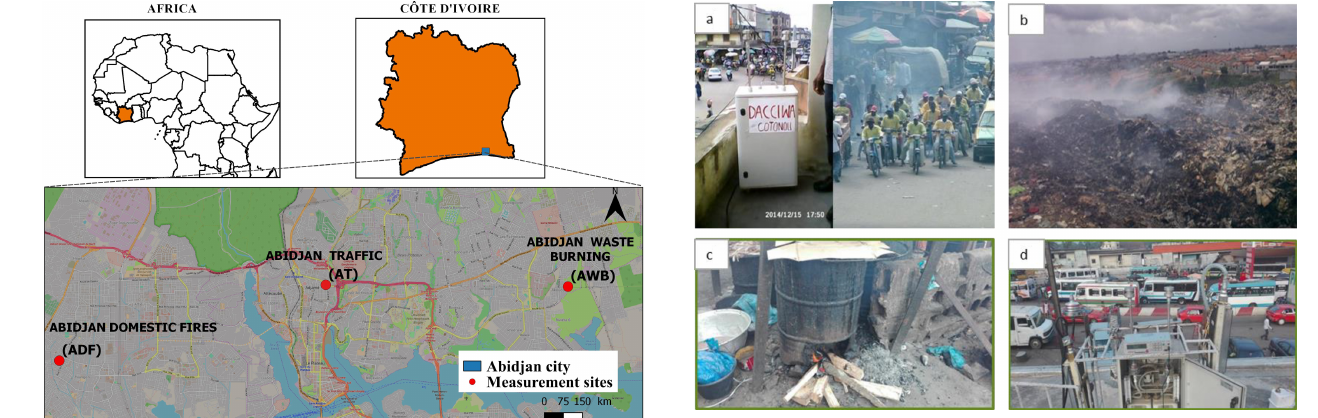
Figure 1. Map of the city of Abidjan reporting the geographical location of DACCIWA urban sampling sites.